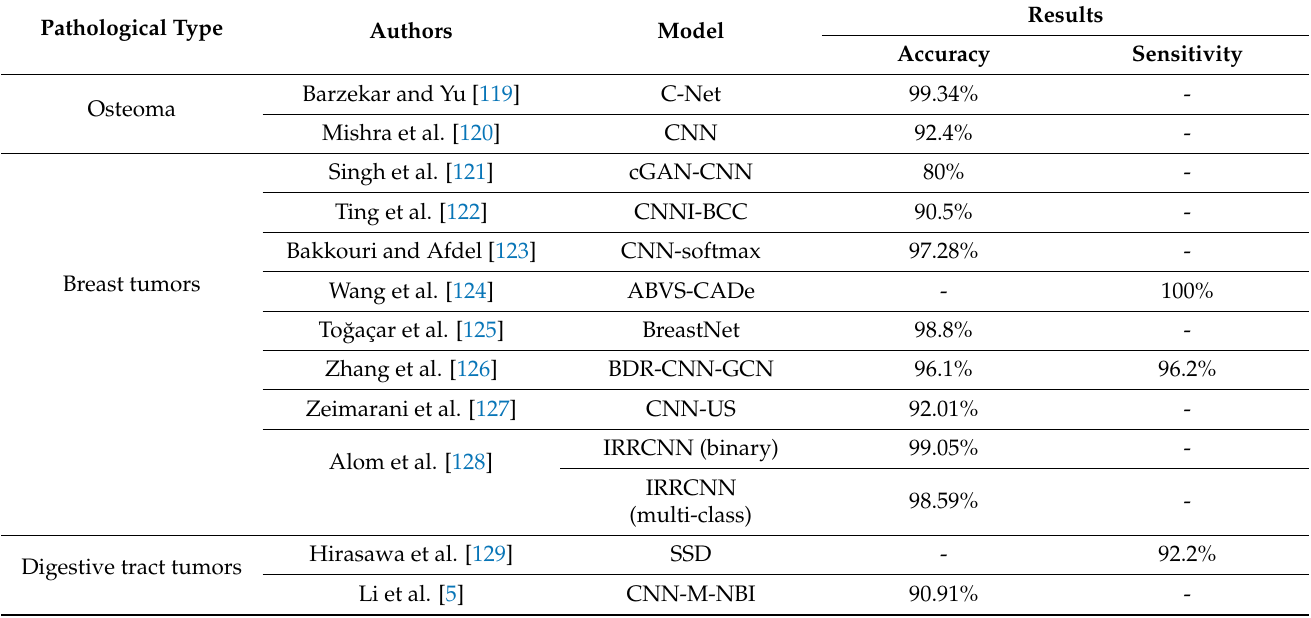
Table 6. Results of the application of convolutional neural networks in other tumor fields. Pathological